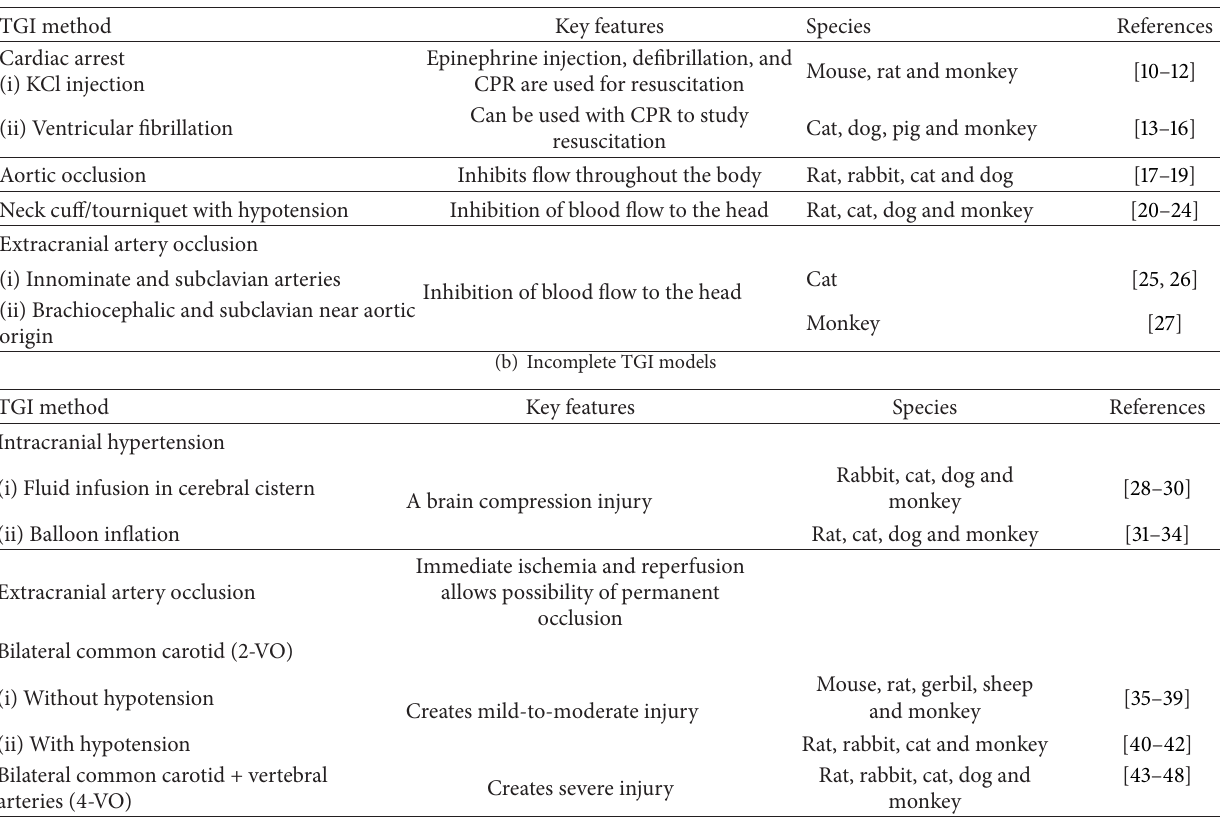
Table 1: Experimental models of transient global ischemia.